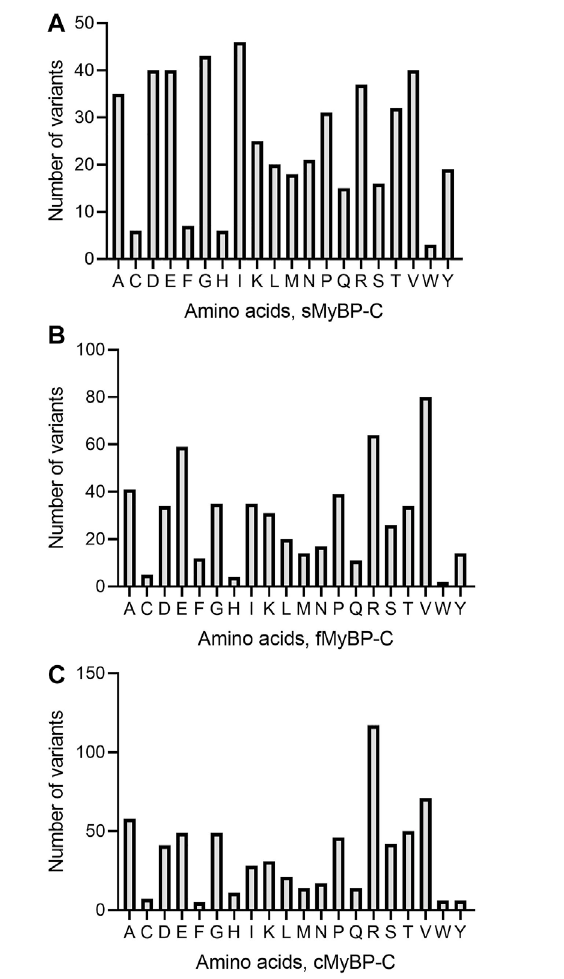
FIGURE 5 | Prevalence of amino acids in missense variants across paralogs. Arg(R)wasthemostmutatedaminoacidinmissensevariants inthe MyBP-C protein family with Val (V) being the second most mutated in sMyBP- C (A) ,fMyBP-C (B) andcMyBP-C (C) .Iso(I)wasanotherhighlymutated amino acid in missense variants in the cMyBP-C